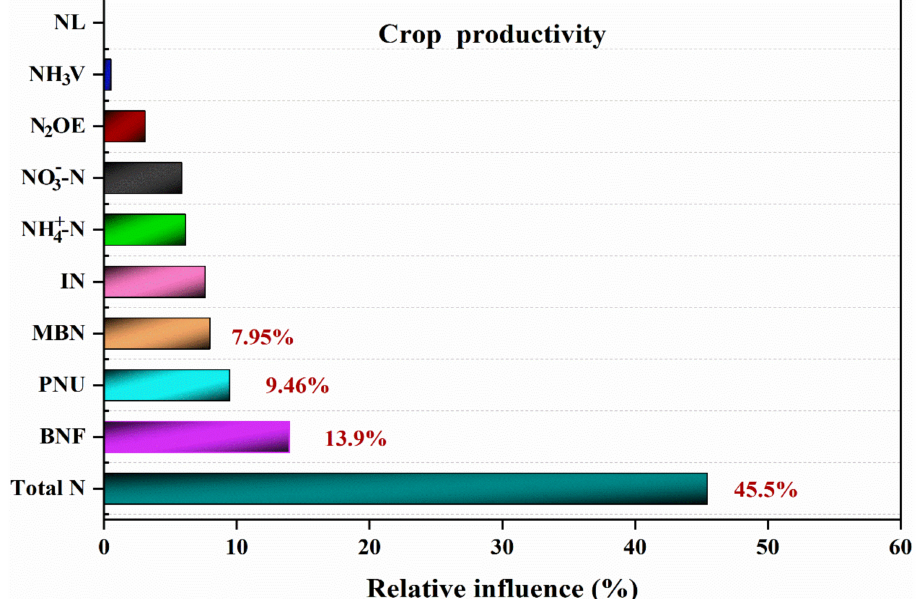
Figure 5. The relative influence (%) of the effects of soil N dynamics (i.e., microbial biomass N (MBN), inorganic N (IN), ammonium N (NH 4+ -N), nitrate N NO 3 − -N), NH 3 volatilization (NH 3 V), N 2